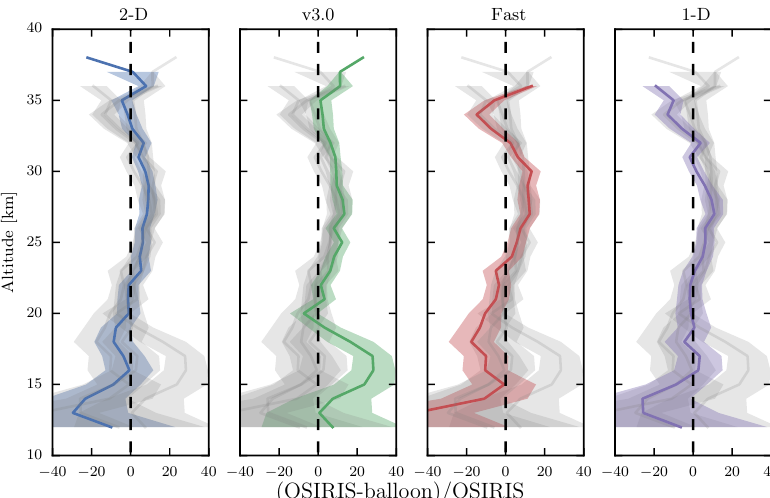
Figure 6. Median of individual biases vs. balloon data. The error bar shows ± 1 standard error of the median NO 2 bias profile. The median and standard error of the individual biases are converted to relative quantities by dividing by the corresponding median OSIRIS NO 2 profile (scaled to balloon local time). The relative median bias profiles for the other three algorithms are shown in grey for comparison.